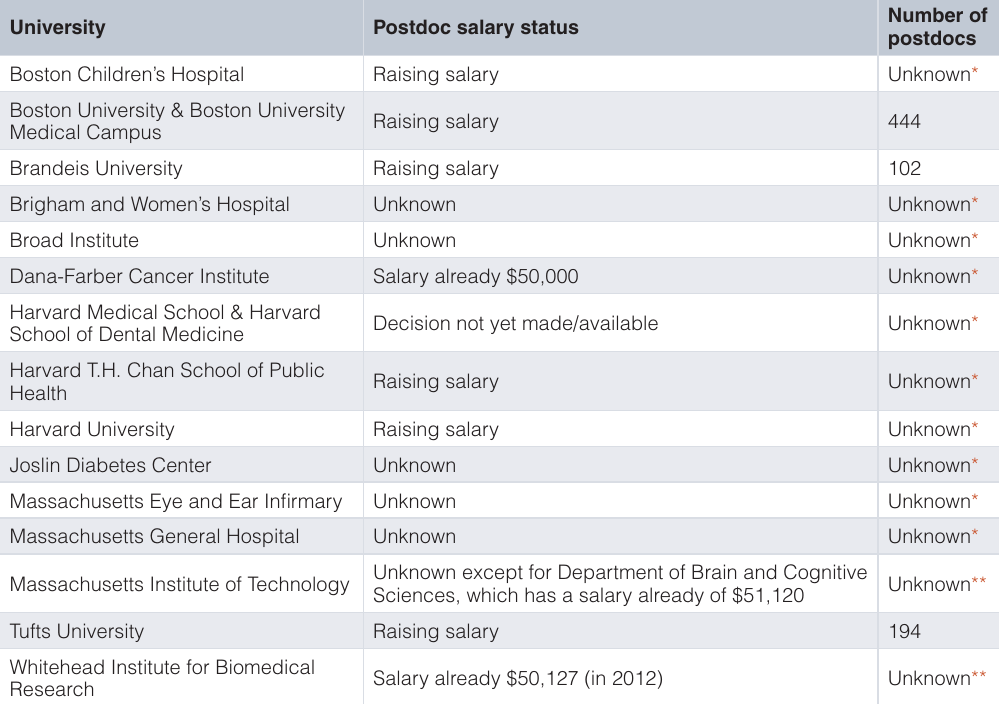
Table 1. Postdoctoral salary status and the number of postdoctoral researchers at various universities in Boston. *Unknown number out of 5,761 at “Harvard” and **Unknown number out of 1,516 at